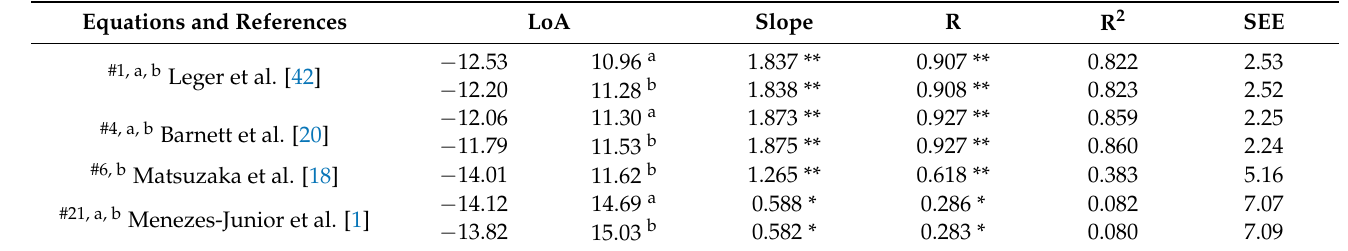
Table 6. Predictive equations using a Bland–Altman approach as compared with measured VO 2 peak values (mL/kg/min).